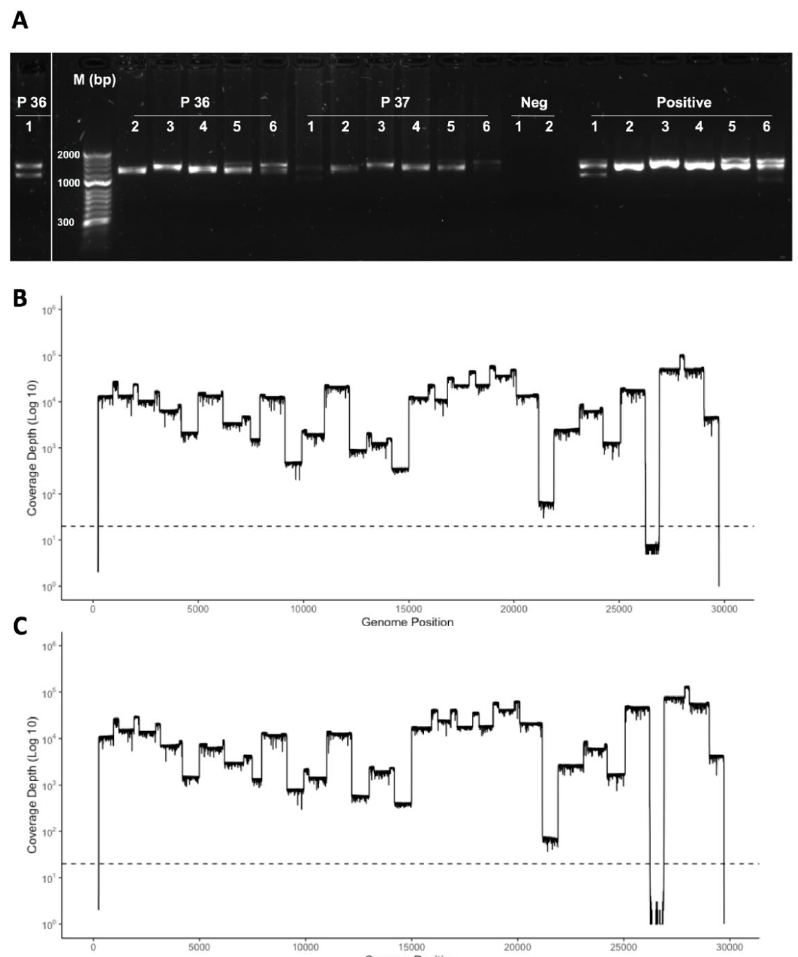
Figure 4. ( A ) Agarose gel electrophoresis analysis of amplicons generated by multiplex RT-PCR from RNA isolated from a nasopharyngeal swab taken from patients who had COVID-19 and diagnosed positive for SARS-CoV-2 by a laboratory-based test. Primer pairs are indicated above each amplicon and exemplar data from two patients (numbers 36 and 37) are shown. Note that amplicons from multiplex pool 1, for patient 36, is shown to the left as these were run on a separate gel. Also shown are negative controls and a positive control using RNA isolated from SARS-CoV-2 infected cells. ( B , C ) The amplicon products were purified, barcoded and sequenced on a single flow cell using an Oxford Nanopore MinION. Shown are the number of reads that map ( y -axis) to each amplicon across the SARS-CoV-2 genome from 5 (cid:48) to 3 (cid:48) ( x